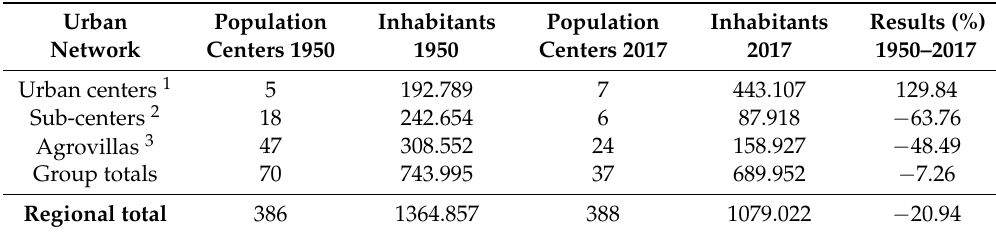
Table 1. The urban network of Extremadura